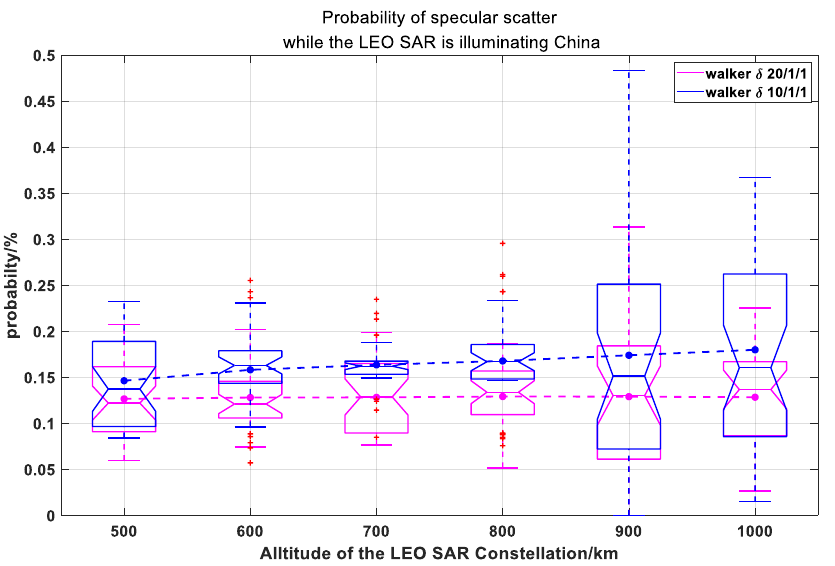
Figure 12. Probability of specular scatter while the LEO SAR is illuminating China. The magenta box line shows the case of a LEO SAR constellation which uses a 20/1/1 walker pattern. The magenta points are the average of the probability for every altitude in 20/1/1 walker pattern. The blue box line shows the case of a LEO SAR constellation which uses a 10/1/1 walker patten. The blue points are the average of the probability for every altitude in 10/1/1 walker pattern.